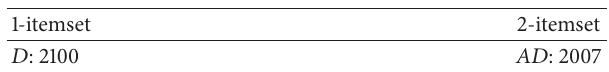
Table 5: Final derived